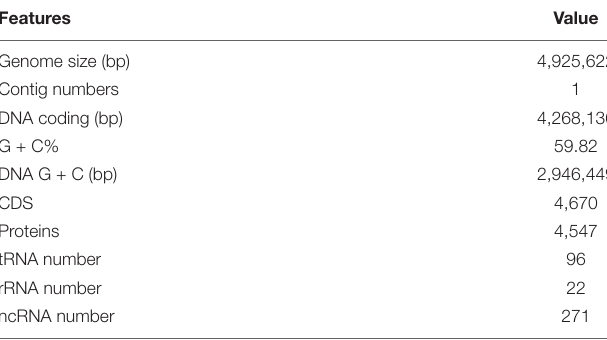
TABLE 2 | Statistics of S. marcescens JW-CZ2 genome